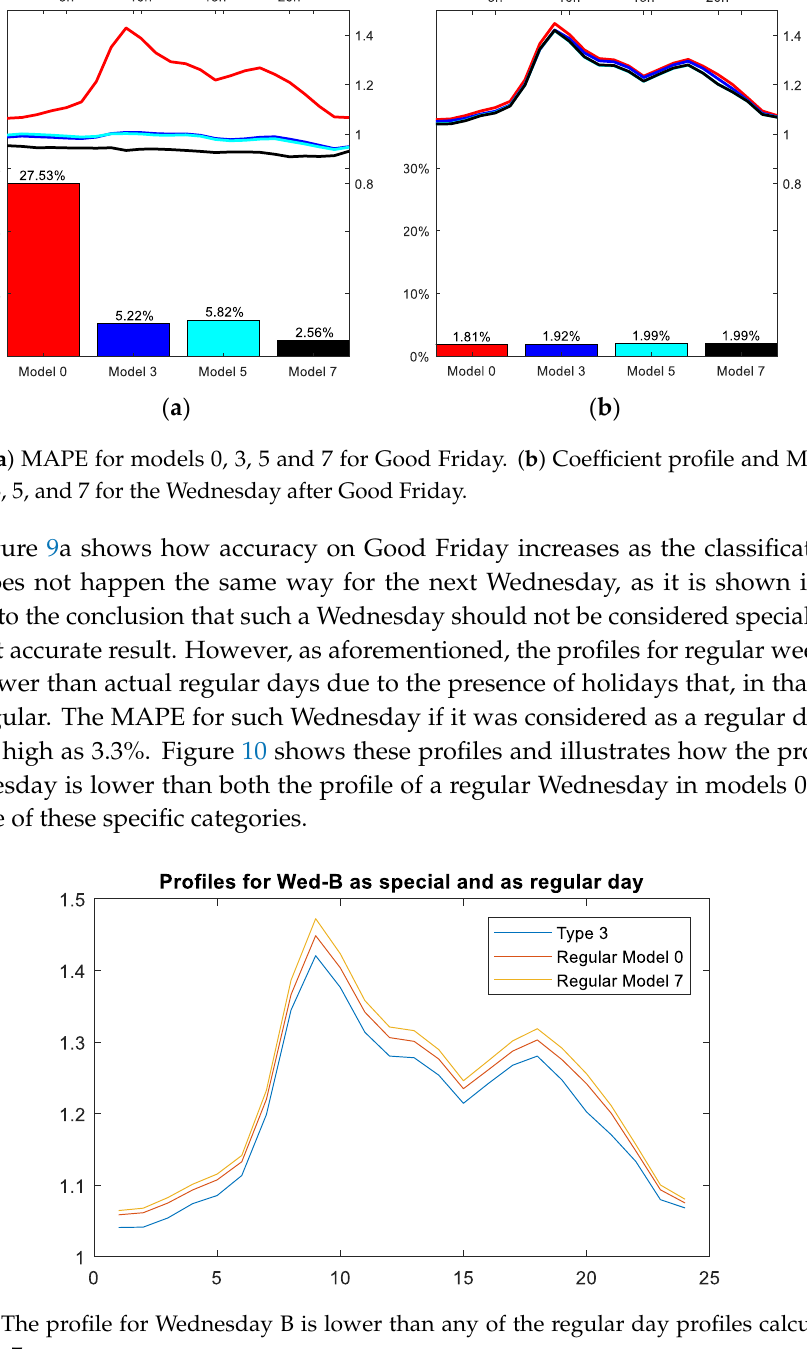
Figure 10. The profile for Wednesday B is lower than any of the regular day profiles calculated in models 0 or 7.